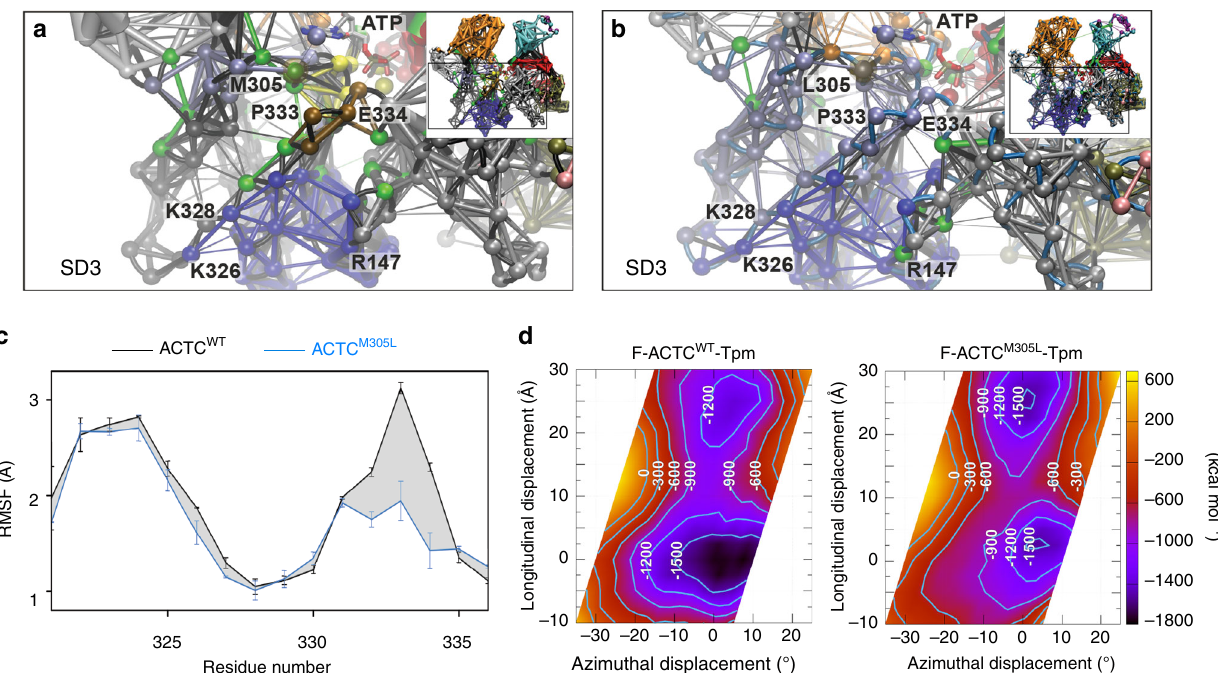
Fig. 6 ACTC M305L exhibits altered communication pathways and coupled motions and distorts F-actin – Tpm electrostatic energy landscapes. a Dynamical network analysis of cMD simulations of an ACTC WT Tpm-interacting subregion revealed a high degree of coupled motions, represented by the thickness of the connections and weighted according to the correlation data obtained from PCA. Clustered network communities were identi fi ed using the Girvan – Newman algorithm and colored individually, indicating regions of concerted movements. Critical residues and connections between two network communities are presented in green. P333 and E334 formed a separate community (brown) that maintained some fl exibility and moved independently with respect to K326 and K328. Inset: dynamical network analysis of an entire ACTC WT protomer (see Supplementary Fig. 10A) demarcating the enlarged region discussed above. b Dynamical network analysis of cMD simulations of ACTC M305L showed that the coupled motions of the Tpm-interacting subregion around P333 and E334 differed from those of ACTC WT and moved in concert with K326 and K328 and the community surrounding L305 (light blue). Inset: dynamical network analysis of an ACTC M305L protomer (see Supplementary Fig. 10B) demarcating the enlarged region discussed above. c Root mean square fl uctuations (RMSF) of C α atoms along a stretch of actin residues that forms stable interactions with and facilitates inhibitory positioning of Tpm, measured over the course of enhanced sampling MD simulations. Data are represented as mean ± SEM ( n = 2). d Average electrostatic energy landscapes for wildtype (left) and M305L F-actin – Tpm (right). The origin is set at 0,0, which represents the previously determined energy minimum of the inhibitory, A/B con fi guration for wildtype F-actin – Tpm 24 , where Tpm is located in a position that would impede myosin binding. The plot is contoured with isolines between − 1500 and 0 kcal mol − 1 in increments of 300 kcal mol − 1 . Note, the broad well around the origin in the wildtype plot is shallower and narrower in the mutant F-actin – Tpm plot. Additionally, a second equivalent energy well is located distal to the A/B site along the mutant fi lament, which might be predicted to bias Tpm to a non-inhibitory location. Source data are provided as a Source Data fi